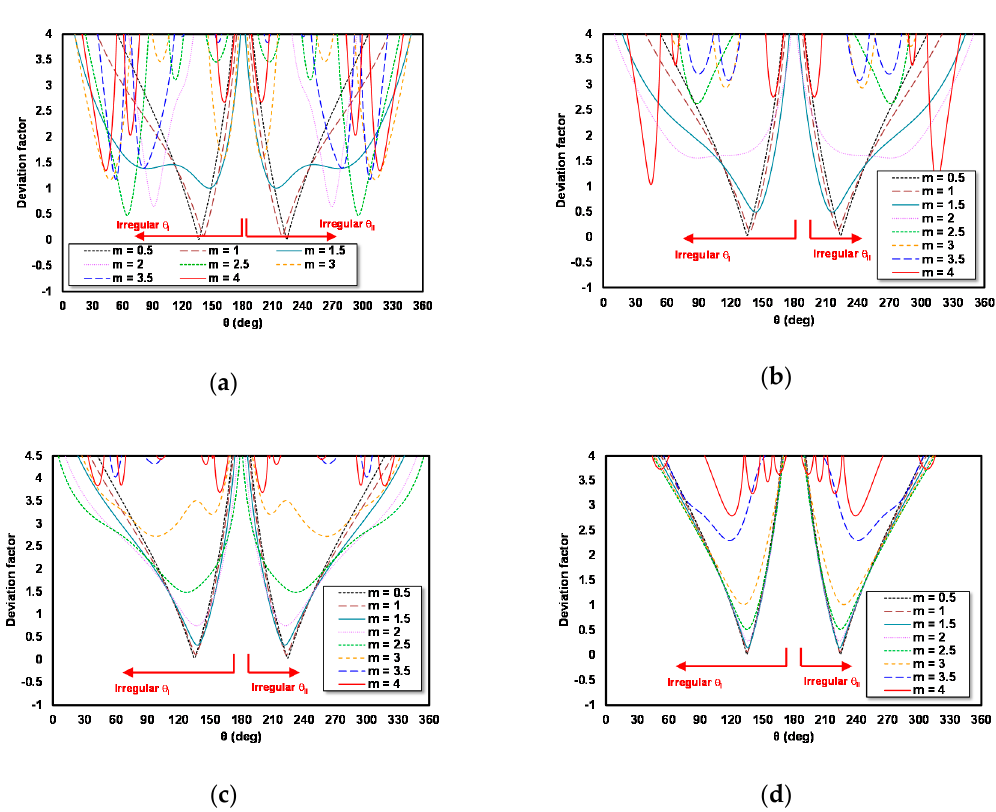
Figure 5. Deviation factor as the θ function for ( a ) scheme A1; ( b ) A2, ( c ) A3; and ( d ) A4. Photonics 2020 , 7 , x